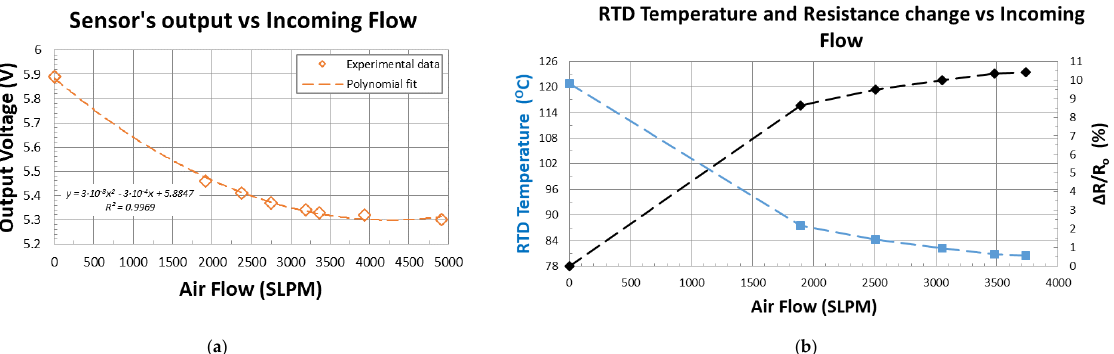
Figure 12. RTD on High Velocity Bypass. ( a ) Sensor’s output vs. incoming flow; ( b ) RTD temperature and resistance change vs. incoming flow.